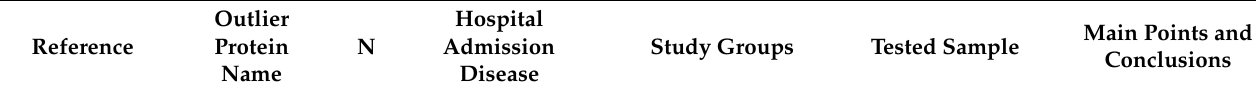
Figure 4. Venn diagram showing the number of proteins found in all study groups and proteins found only in one group. Specific proteins for each group are listed in boxes adjacent to the respective group. Proteins found to be potentially biologically relevant in CKD (according to the previously published literature) are shown in bold. Table 2. Relevant articles pertaining to notable group-specific proteins and its link with the degree of kidney